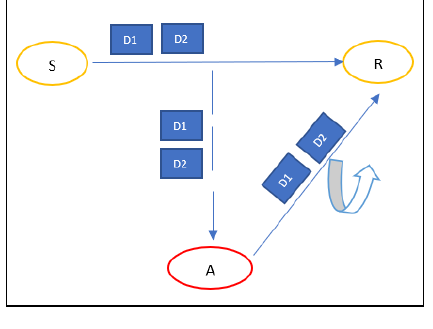
Figure 9:Replay Attack